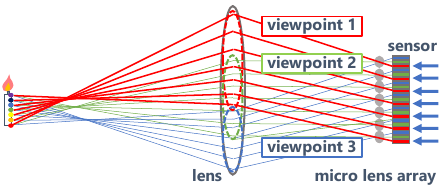
Figure 3. Multi-view images generation